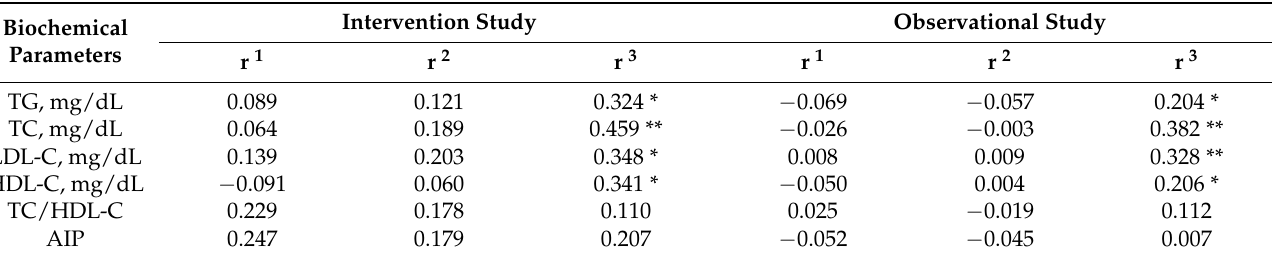
Table 5. Partial correlations (r) between biochemical serum parameters and dairy for the samples taken in the intervention study and the observational